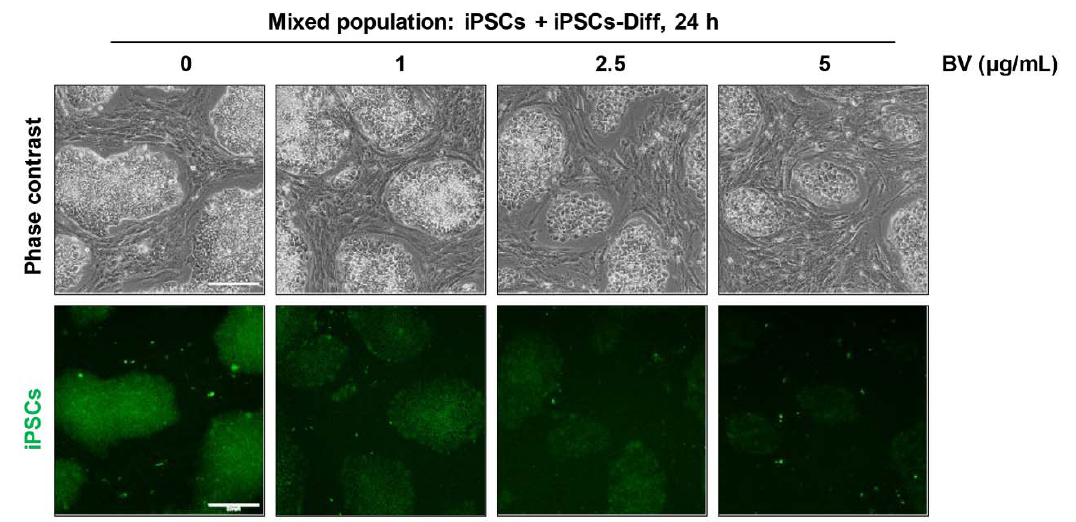
Figure 7. Selective elimination of iPSCs co ‐ cultured with iPSCs ‐ Diff. CellTracker green CMFDA dye ‐ labeled iPSCs and un ‐ labeled iPSCs ‐ Diff were co ‐ cultured, and treated with indicated concentrations of BV. After 24 h, cells were observed under an inverted microscope and a fluorescence microscope. Scale bar = 200 μ m.